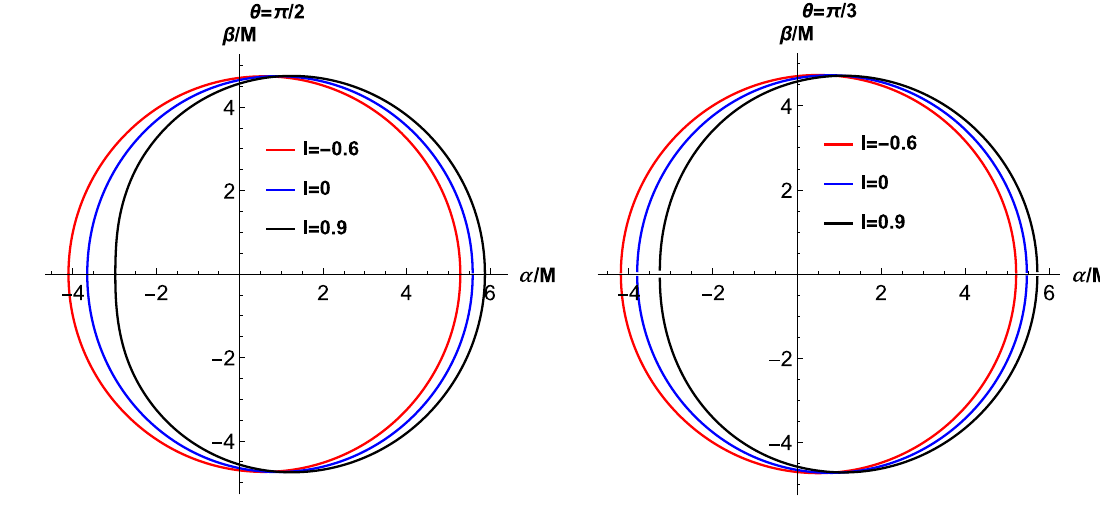
and θ = π with a = 0 . 4 , b = 0 . 5, and k = 0 . 2 2 3